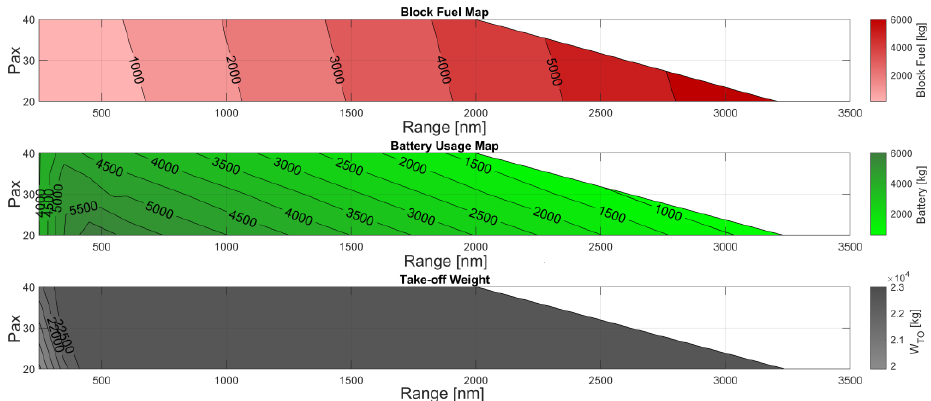
Figure 22. Fuel, battery and take-off mass trends in the whole pax – range diagram ( Swap limited ).